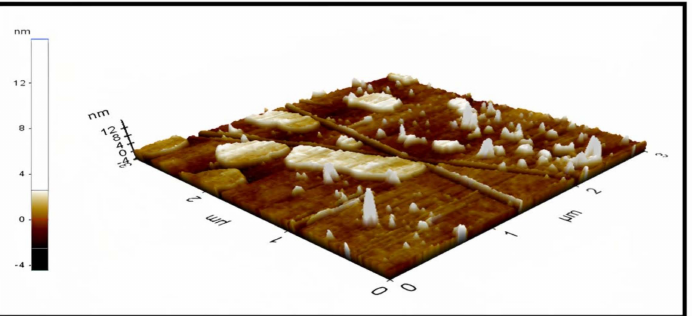
Figure 11. Atomic force microscopy image of optimum curcumin–NLC F1 determining the morphol- ogy of the prepared nano lipids (size area 3 × 3 µ m).